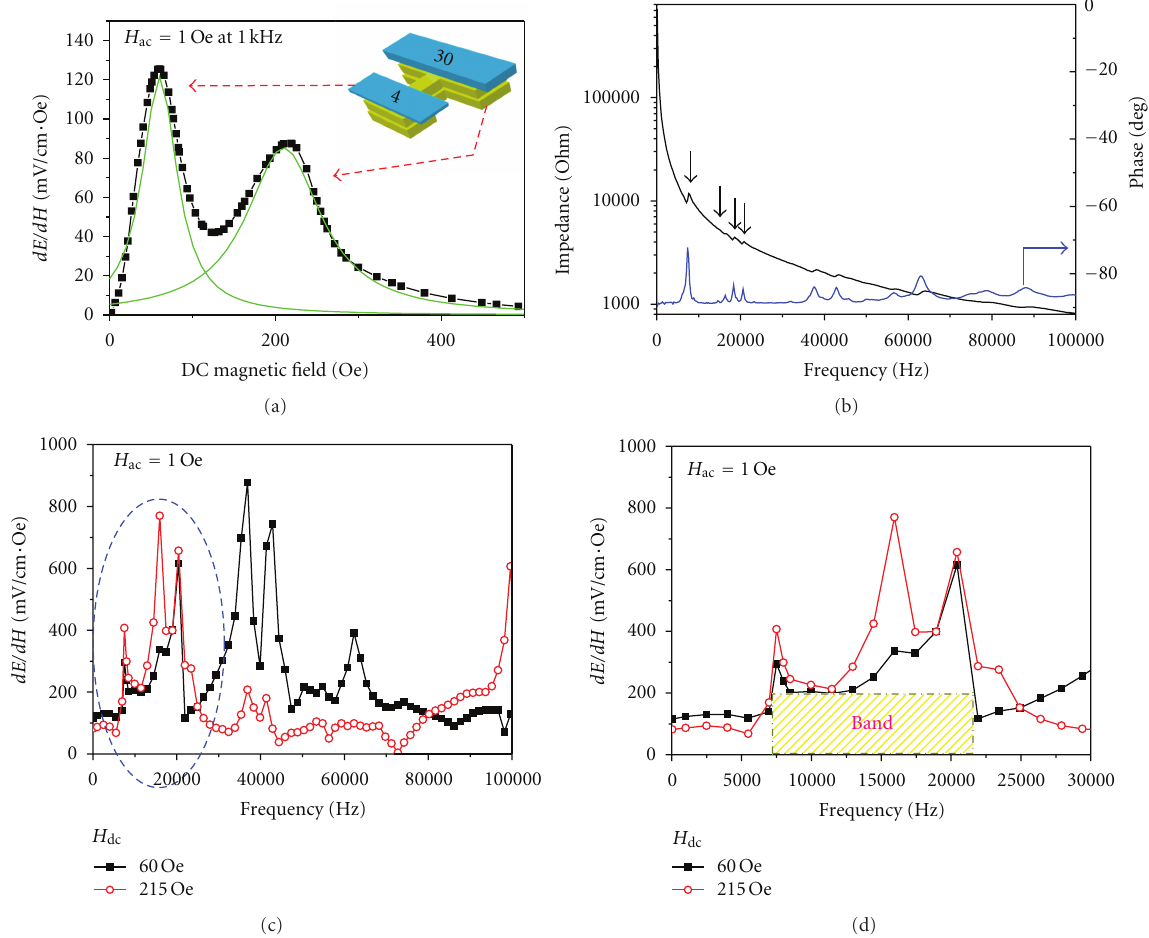
Figure 12: (a) ME coe ffi cient as a function of magnetic DC bias at frequency of 1 kHz and applied AC magnetic field of H ac = 1Oe. Inset: schematic diagram of Metglas attached to the bimorph. Four layers of Metglas of area 15 × 7 mm 2 were attached on smaller rectangular section while thirty layers of Metglas of area 20 × 7mm 2 were attached on the larger rectangular section, (b) impedance and phase spectrums as a function of frequency, (c) ME coe ffi cient as a function of frequency until 100 kHz, and (d) wideband ME behavior as a function of frequency until 30kHz